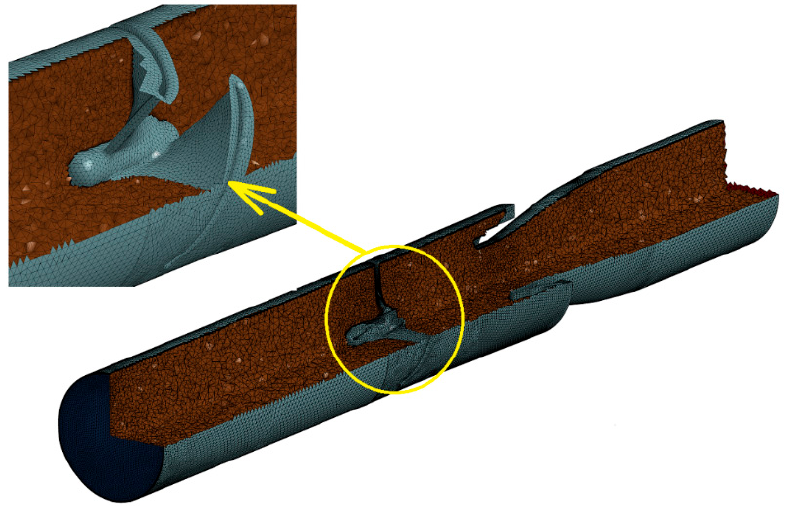
Figure 5. Flow domain in axial flow cyclone.